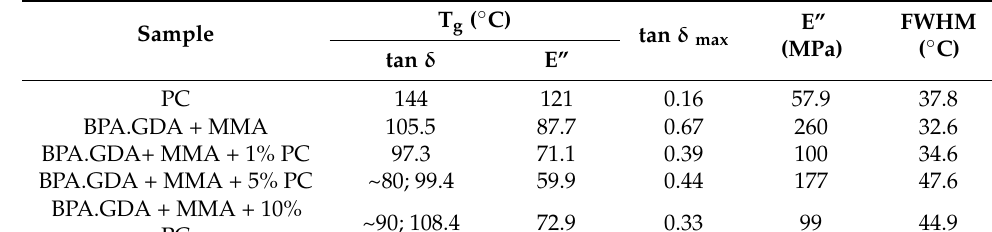
Table 4. Dynamic mechanical analysis (DMA) data of obtained materials.